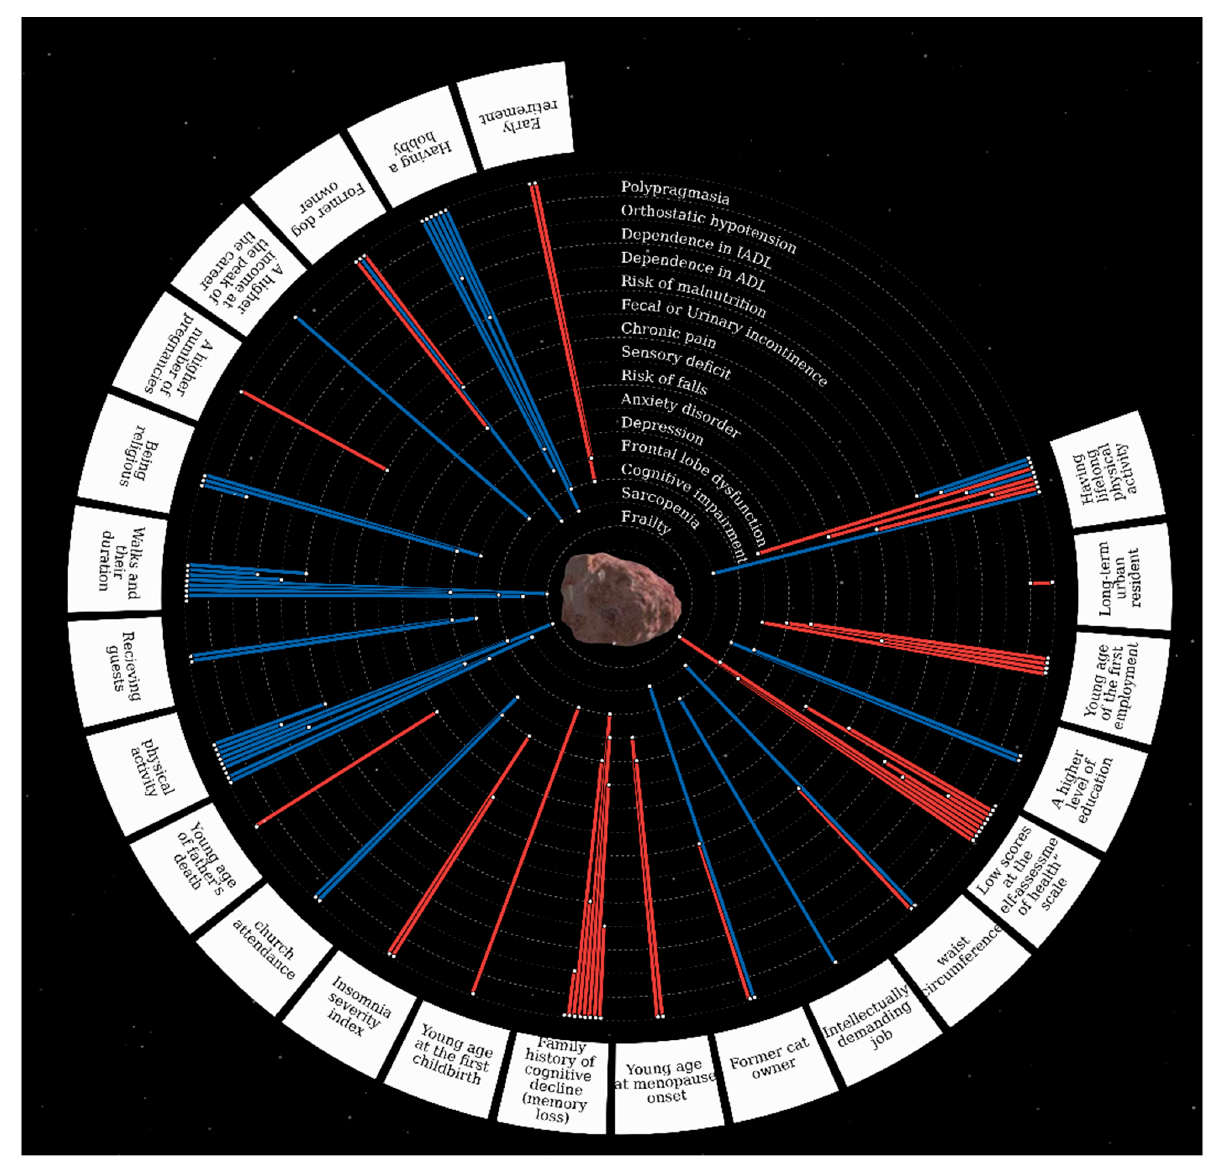
Figure 3. The associations between the GSs and evaluated factors.* The centerpiece Ananke (from Ancient Greek Ἀνάγκη for inevitability, fate, adversity, and necessity) is Jupiter’s satellite, also known as Jupiter XII. Geriatric syndromes are located in orbits around the satellite. Risk factors for geriatric syndromes are located along the outer contour. The red line means the direct relationship between the risk factor and GSs, the blue line means the inverse relationship (protective factors). Table 2. The statistically significant associations between the GSs and evaluated factors ( p -value <0.001).